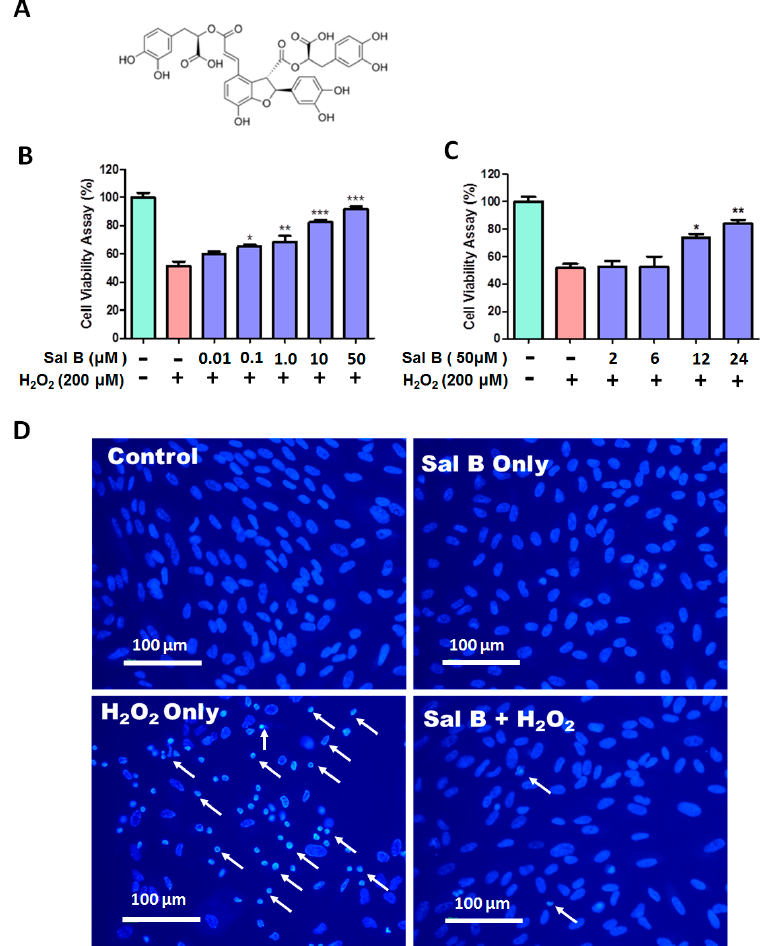
Figure 1. The protective effects of salvianolic acid B (Sal B) on H 2 O 2 -induced cytotoxicity in